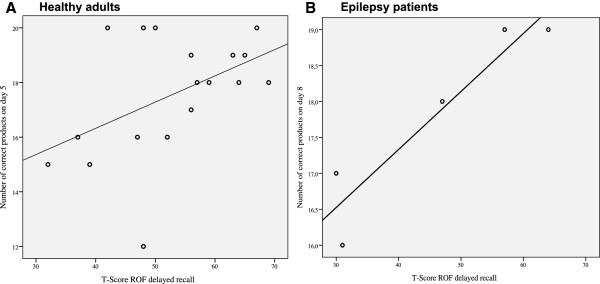
Correlations between the delayed recall of the ROF and the number of correct products for the healthy adults (A) and the epilepsy patients (B). The x- axis represents the delayed recall of the ROF after a 30’ delay and is given in T-Scores (M = 50, SD = 10). The y- axis represents the free recall of the target list on day 5 (A) and day 8 (B), respectively. ROF = Rey–Osterrieth Figure.